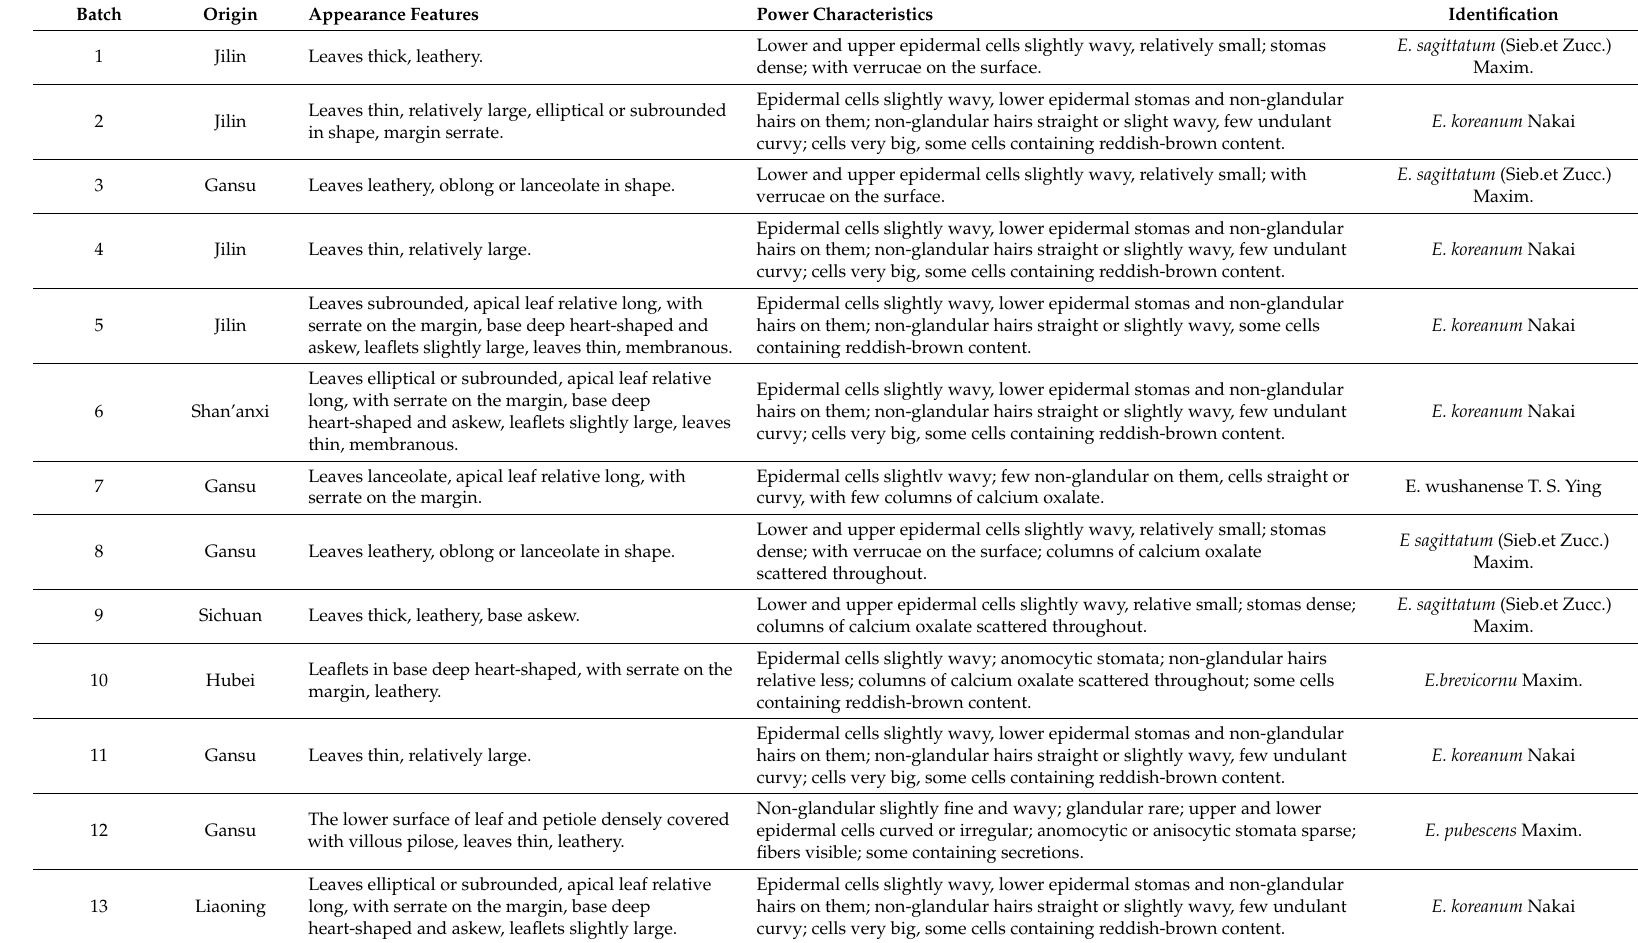
Table 1. Detailed information of 13 batches Epimedium